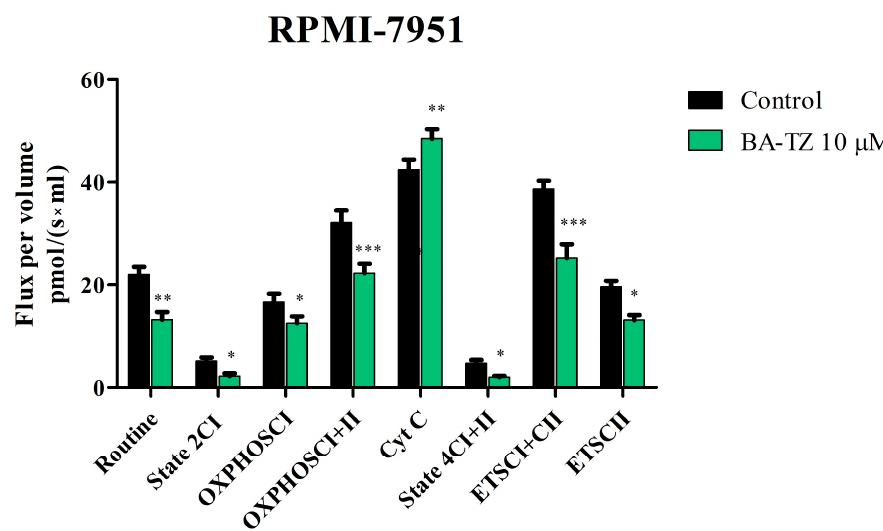
Figure 6. Mitochondrial respiratory rates of permeabilized RPMI-7951 cells following 24 h treatment with BA-TZ 10 µ M. Data represent the mean ± SD of five individual experiments. The statistical differences vs. control was determined using one-way ANOVA analysis followed by Tukey’s multiple comparisons post-test. Values with p < 0.05 were considered to have a statistically significant difference (* p < 0.05, ** p < 0.01 and *** p <